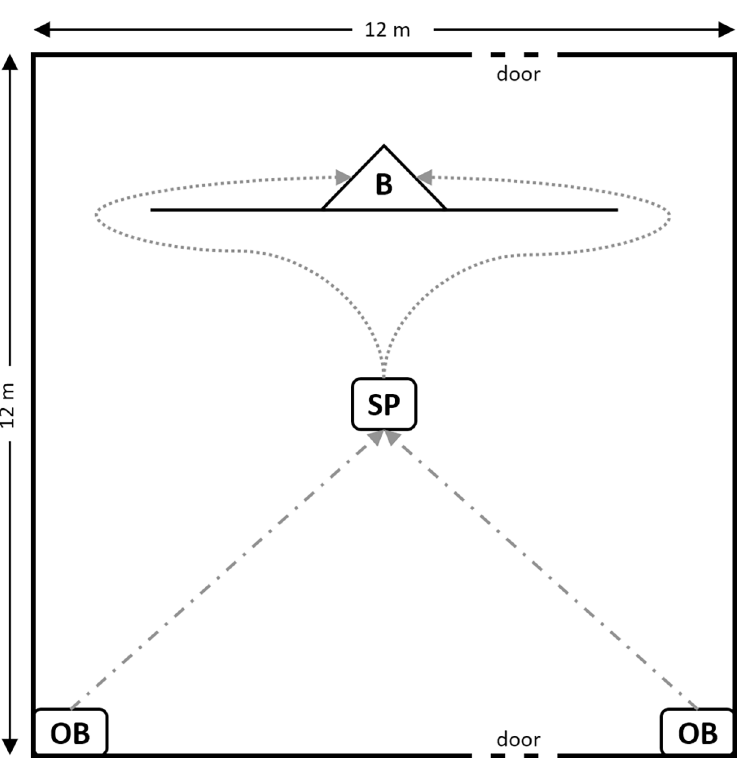
Fig 1. Experimental set-up. OB = possible observation position, B = box behind the wall, in which Experimenter 1 stood during trials, in order to not be visible to the observer, SP = starting position, dashed lines = possible direction an observer was led to the starting position, dotted lines = possible options for an observer to bypass the